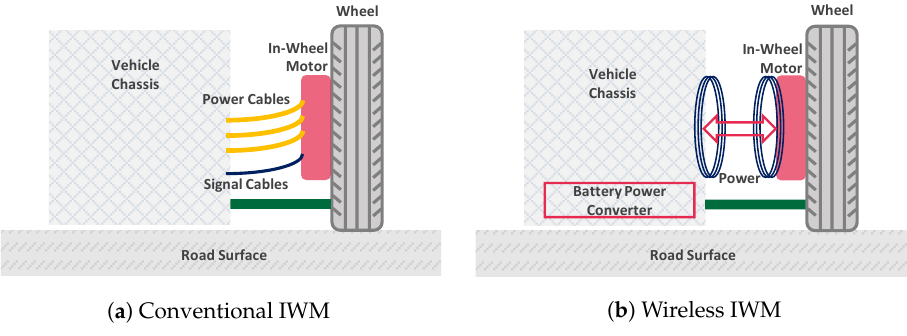
Figure 20. Magnetic flux is produced ( a ) radially along the rotor in RFM ( b ) axially along the axis of rotor in